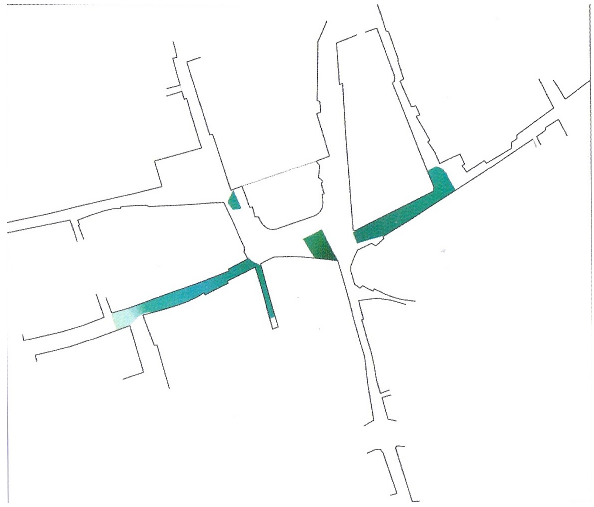
Figure 11: Piazza fontana di Trevi, visualization of sonometer mea- sures. LAeq measures were read at spots in Figure 13 and color was gradated accordingly. White areas (no measurements) denote areas where loud chattering or to vents were too close to the sonometer to reasonably separate the fountain. (reproduced from [36] with permission by